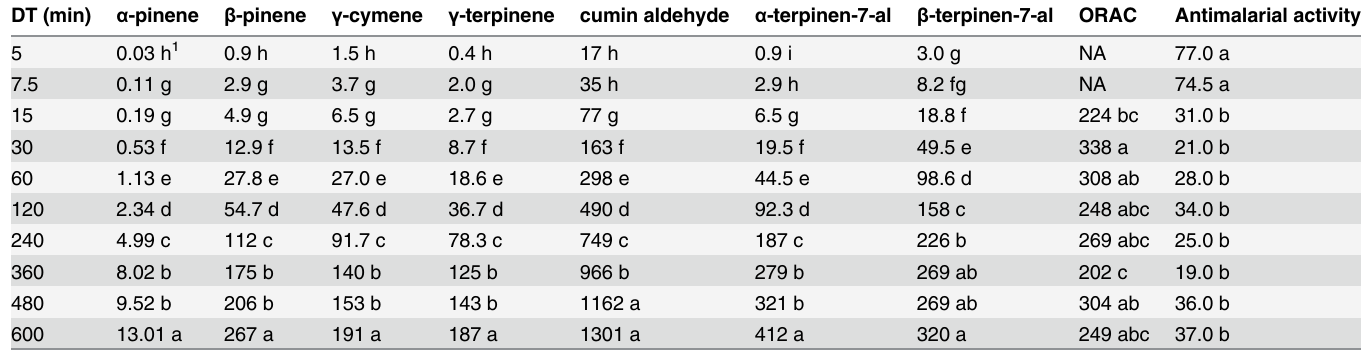
Table 2. Mean yield (mg/100 seed) of α -pinene, β -pinene, γ -cymene, γ -terpinene, cumin aldehyde, α -terpinen-7-al, and β -terpinen-7-al, antioxidant capacity, ORAC (uM Trolox equiv./g), and antimalarial activity (% inhibition) of the cumin seed oils obtained from the 10 distillation times (DT). DT (min) α